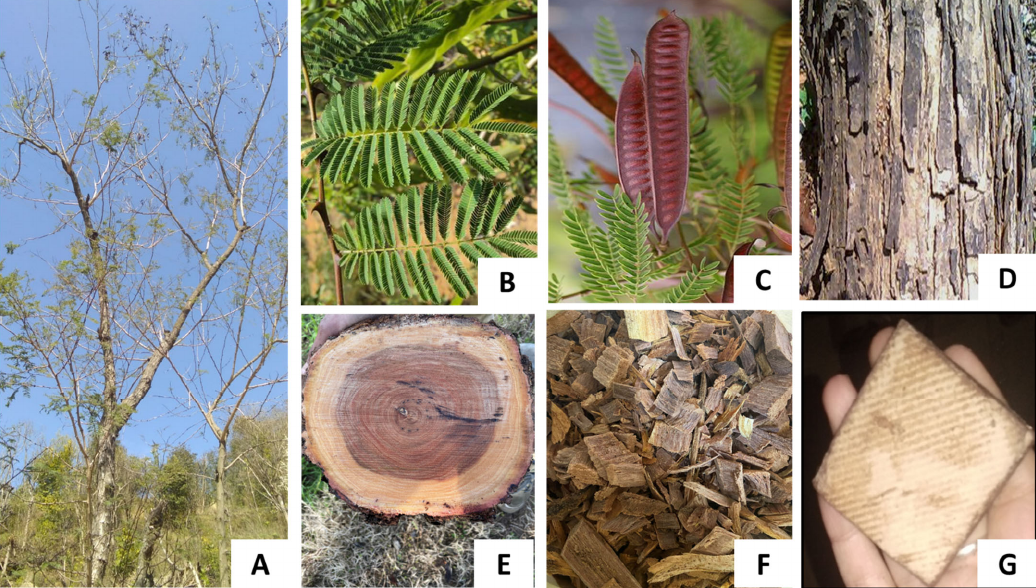
Figure 1. Different parts of Acacia catechu ; ( A ) whole tree, ( B ) leaves, ( C ) fruits, ( D ) bark, ( E ) transverse section of wood, ( F ) heartwood chips, ( G ) concentrated extract shown in this figure.